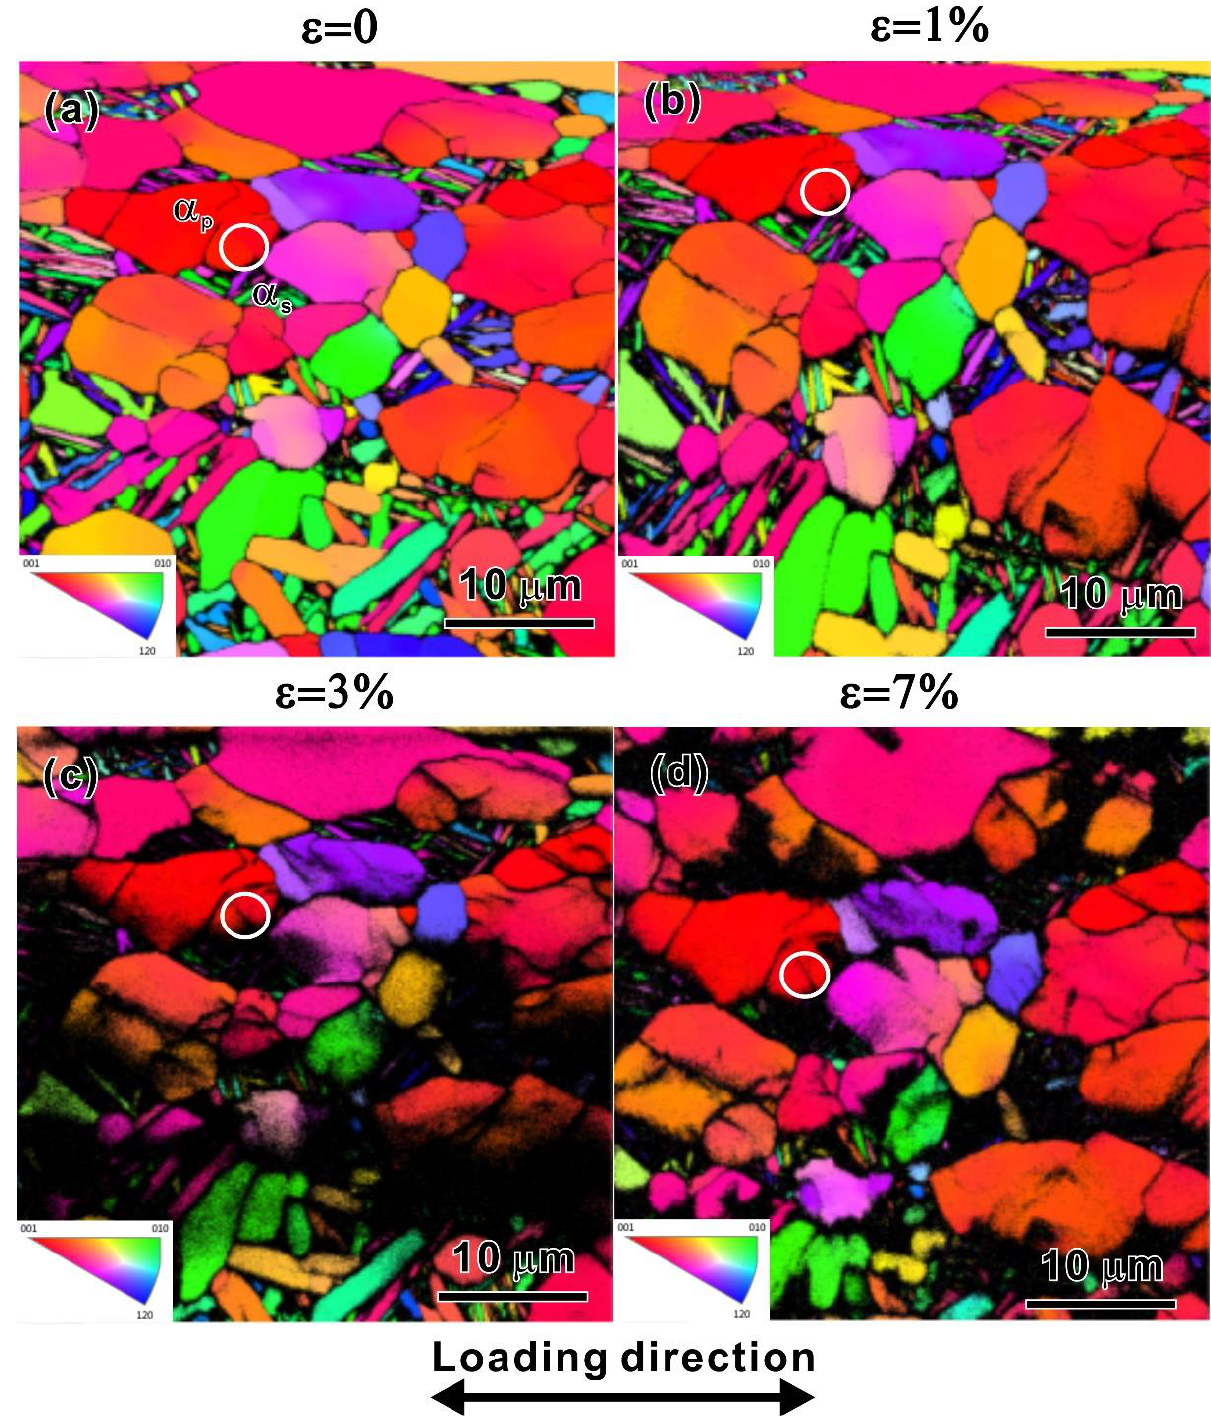
Figure 8. IPF maps of the observation area with strains of ( a ) 0%; ( b ) 1%; ( c ) 3%; and ( d ) 7%, respectively, in a quasi-in situ tensile test.